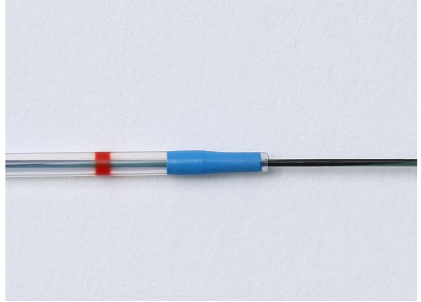
Figure 3. Tapered-tip single-lumen ERCP contrast catheter.